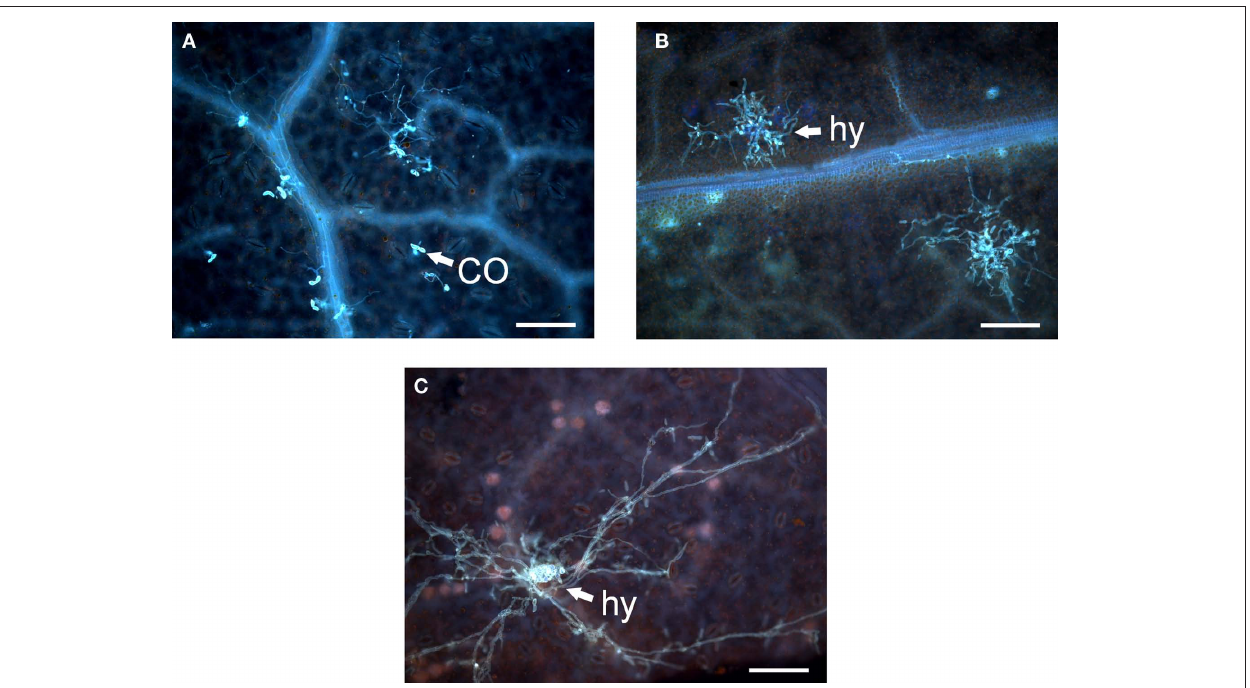
Figure 5 | infiltration of rose leaves with black spot conidia or black spot conidia and Agrobacteria containing various constructs. (A) Resistant genotype 91/100-5 infiltrated with conidia (CO) of Dort E4 and Agrobacterium strain GV3101 harboring pBIN19::GUS-intron. (B) Infiltration of 91/100-5 with